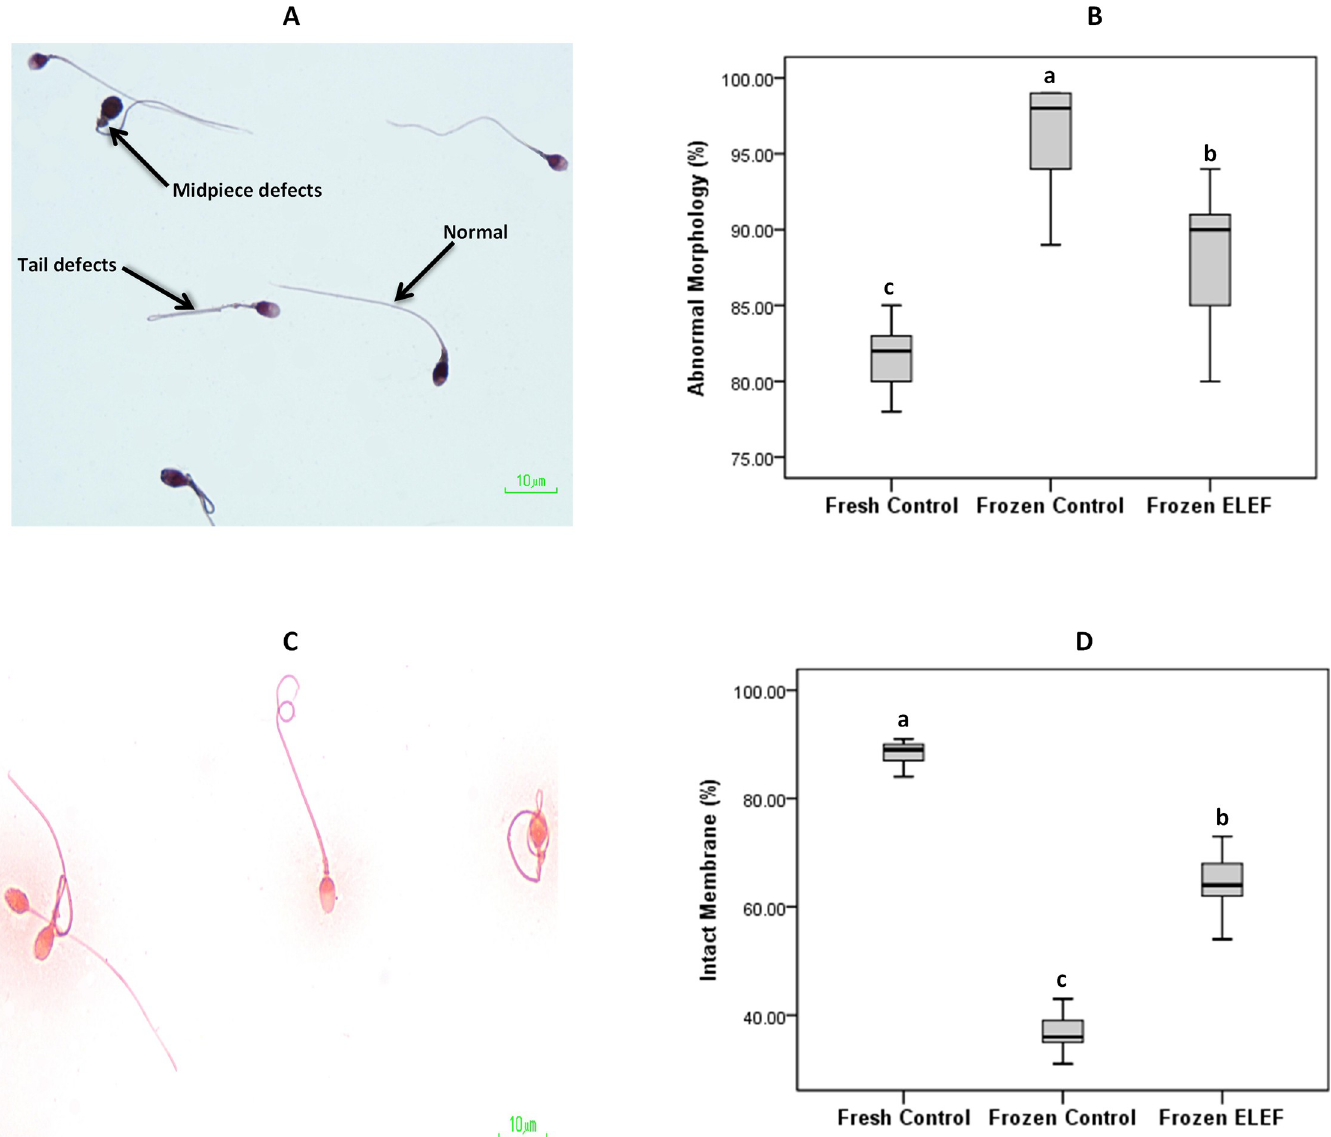
Fig 4. Morphology and membrane integrity. (A) Sperm morphology test; the various types of sperm head, neck and tail defects are analyzed. (B) Box-and-whisker plots for sperm with abnormal morphology from the three groups. Abnormal morphology significantly differs between experimental groups. (C) Graph of sperm exhibiting tail swelling under hypo-osmotic solution as indicated by tail curling while dead sperm show no change. (D) Box-and-whisker plots for sperm with intact membrane from the three experimental groups. Percentage of intact membrane is lower in frozen control than in fresh and frozen ELEF. The assigned letters of a, b and c indicate significant differences (p < 0.05) among the groups. Values are expressed as mean ±